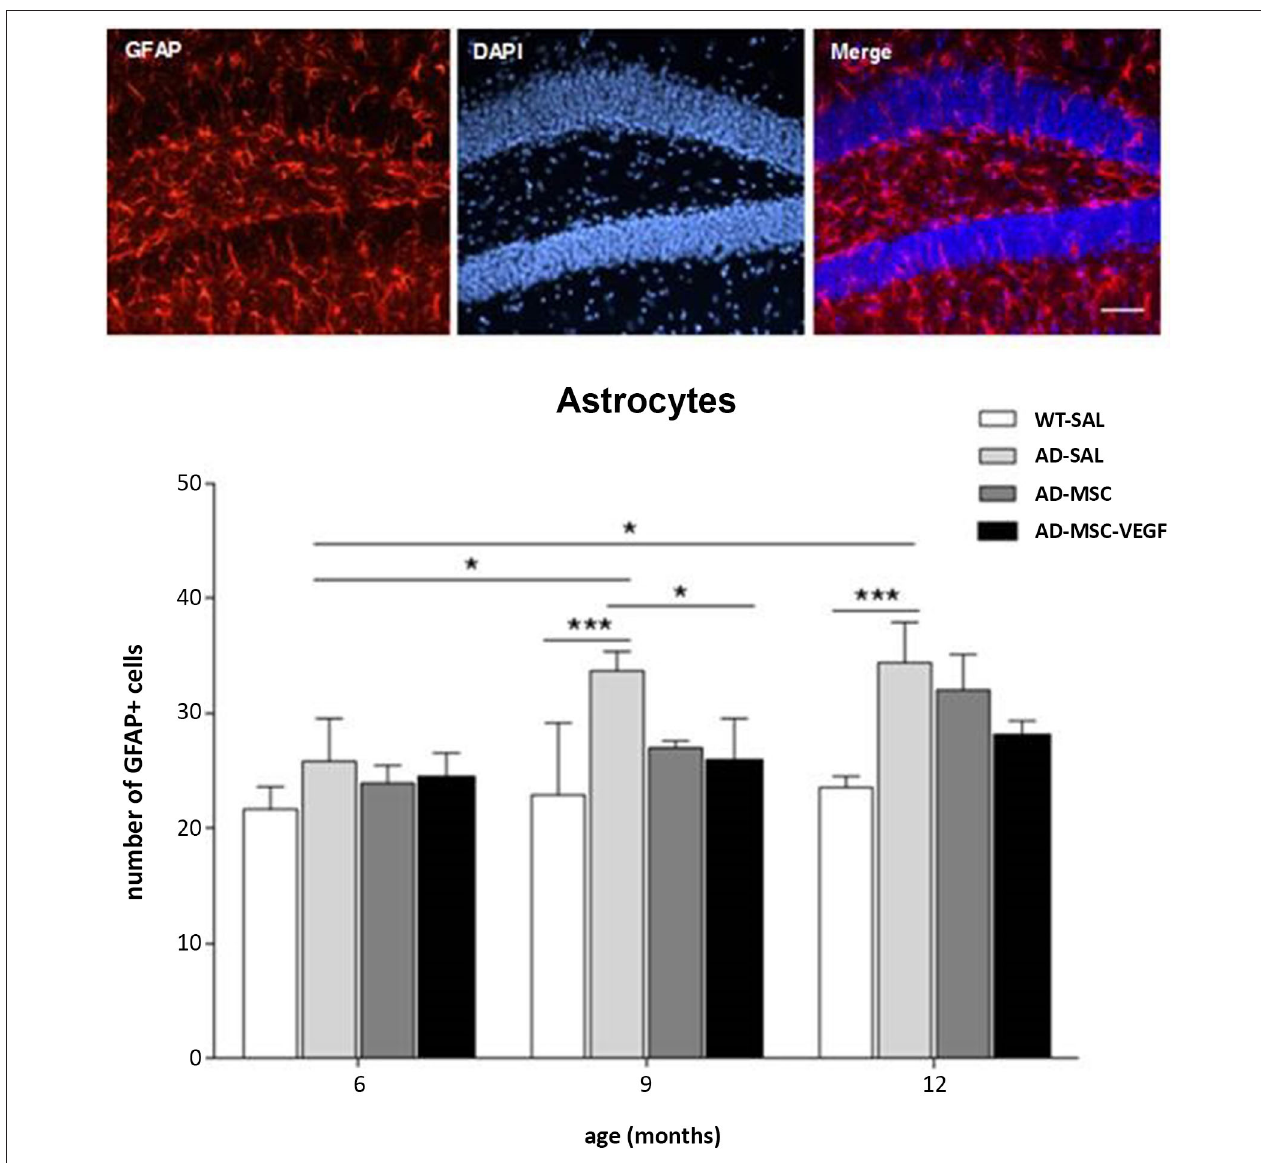
WT, AD-SAL, AD-MSC and AD-MSC-VEGF mice at 6, 9 and 12 months (two-way ANOVA followed by Tukey’s multiple comparisons test, mean ± standard error; * P < 0.05; ** P < 0.01; *** P < 0.001, n = 5 per